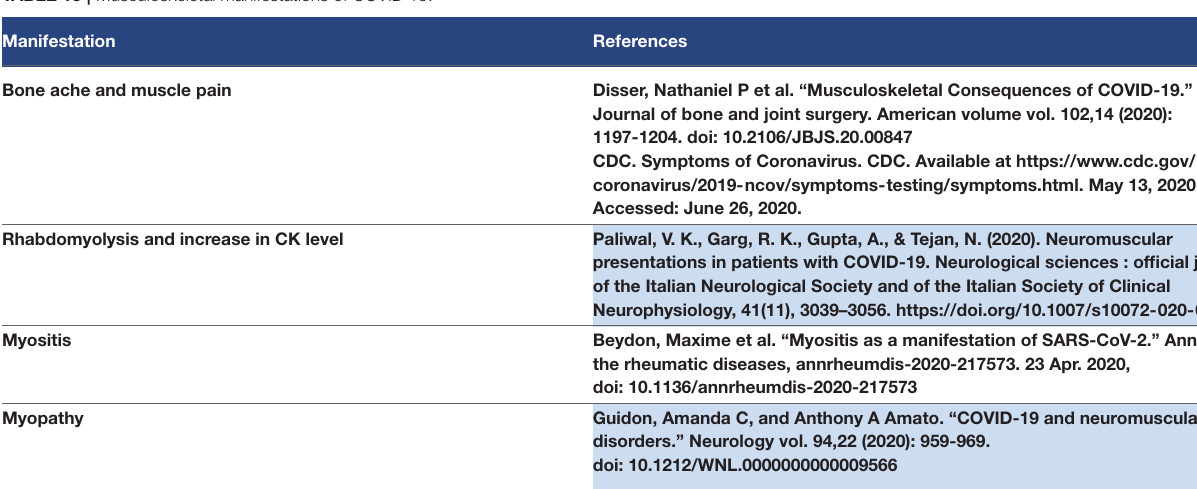
TABLE 13 | Musculoskeletal manifestations of COVID